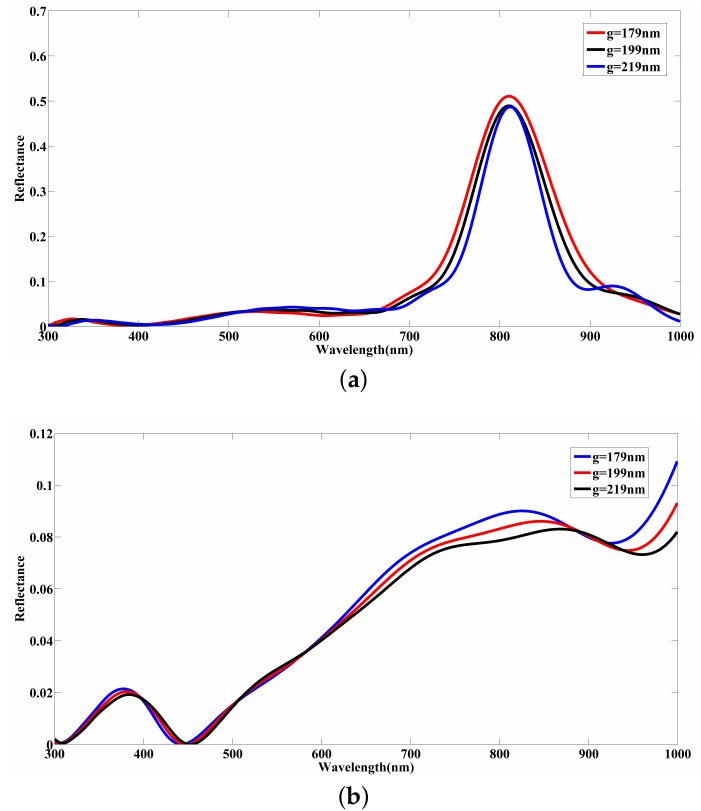
Figure 8. The simulated reflectance spectra arising from the demonstration of COVID-19 model density under changing the distance between COVID-19 particles for two states of the light incidence from ( a ) the top and ( b ) the side